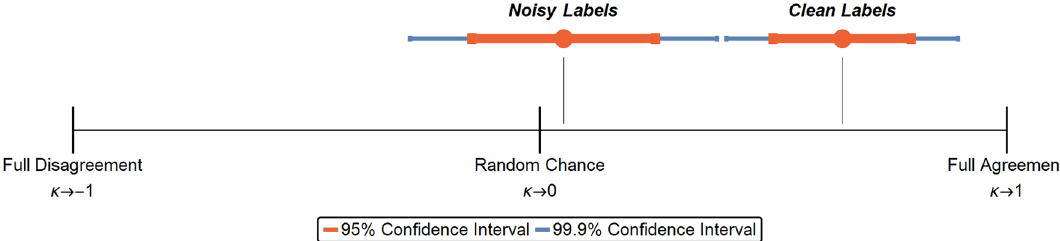
Figure 1. Cohen’s kappa test for noisy and Correct labels shows that images with Correct labels lead to a significantly higher level of agreement than random chance, and significantly higher than those with noisy